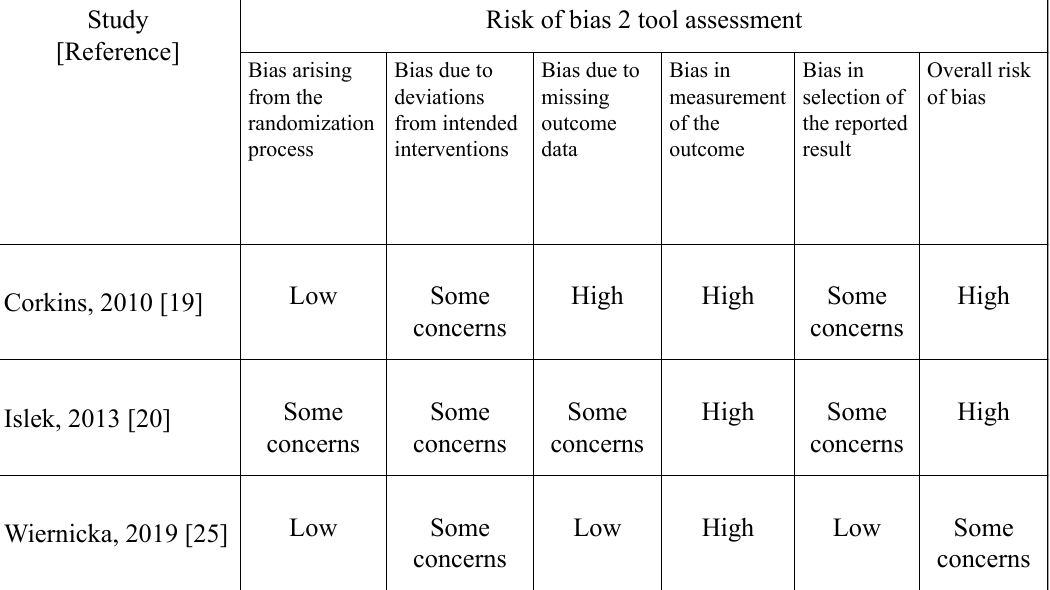
Figure A3. Risk of bias for adverse